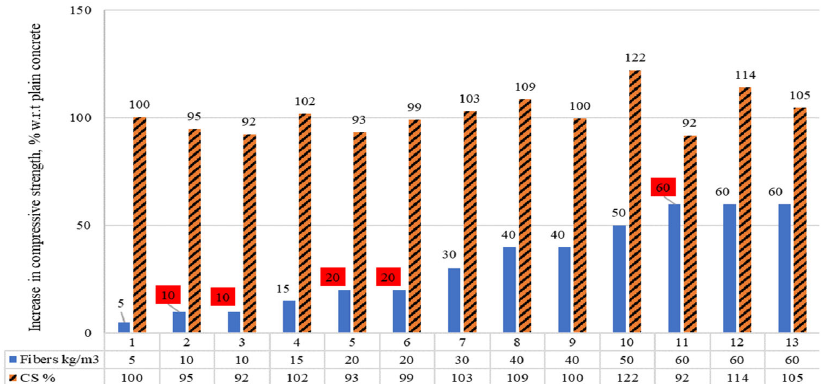
Figure 7. Percentage comparison of the compressive strengths of concrete containing RSF in kg/m 3.